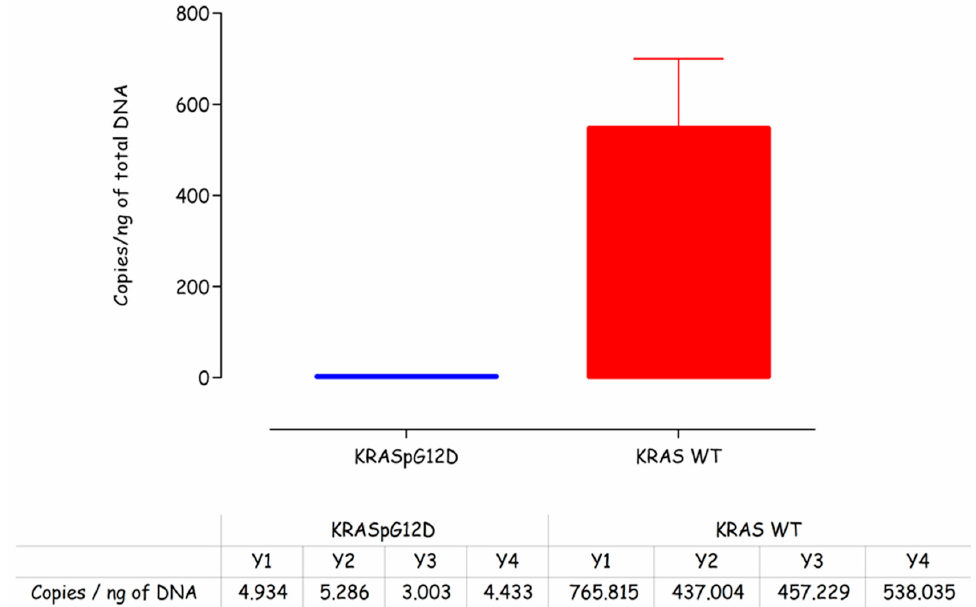
Figure 2. Copies of KRASG12D mutant and KRAS wild type detected in total DNA isolated from SK-UT-1 cells using ddPCR (BioRad QX200).